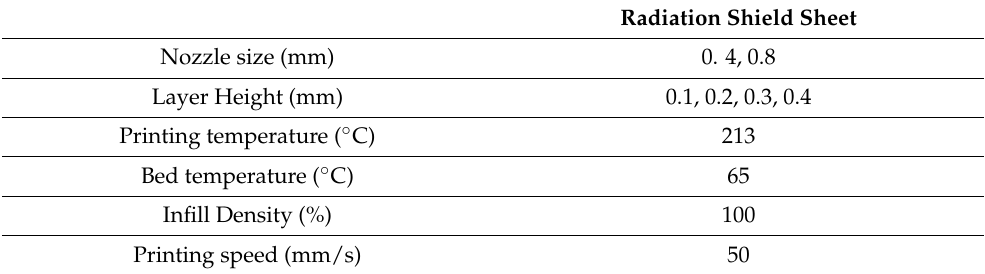
Table 1. T he 3D printer settings.